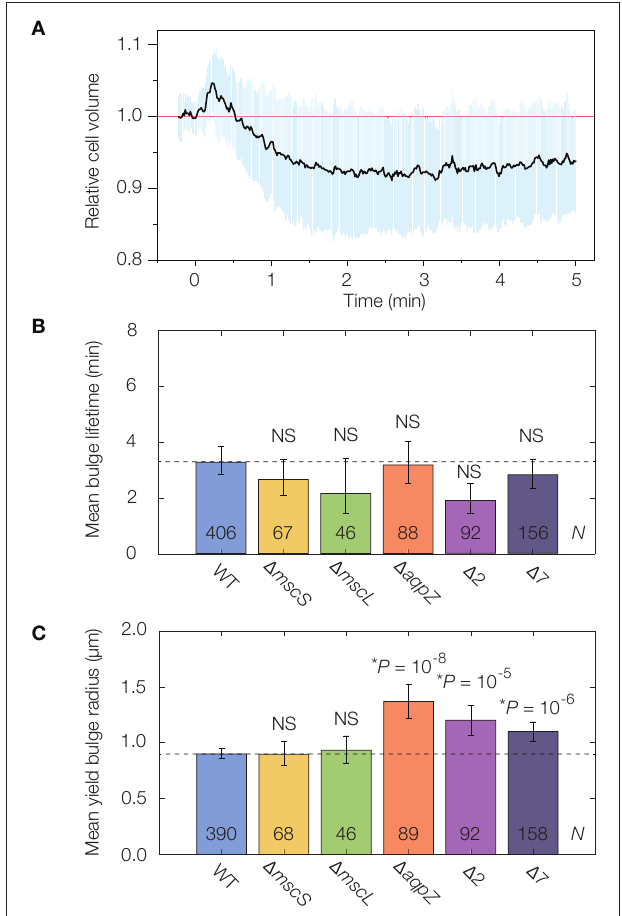
FIGURE 3 | Mechanosensitive channels fail to delay or stabilize cells against lysis. (A) Averaged single-cell volume response of 30 wild-type (parent strain BW25113) cells to a hypoosmotic shock of 600 mM sorbitol at time t = 0 min, indicating volume recovery in ∼ 30 s. Similar traces for the 1 7 strain for an osmotic shock of a similar magnitude show no volume recovery, as detailed in Supplementary Figure 7 . The blue shaded region indicates one standard deviation. (B) Comparison of mean bulge lifetimes between WT cells and MSC mutants. Error bars indicate 95% confidence intervals, and p -values are indicated for a two-sample Kolmogorov-Smirnov test for the difference from wild-type (dashed line). The number of bulged cells ( N ) is indicated on each bar. For detailed histograms, see Supplementary Figure 7 ; for full timelapses of lysing populations, see Supplementary Movies 4, 5 . NS, not significant. (C) Same as (B) , but for mean yield bulge radii. ∗ While the yield bulge radii for the 1 aqpZ , 1 2, and 1 7 strains differ from WT, we note they are not largely